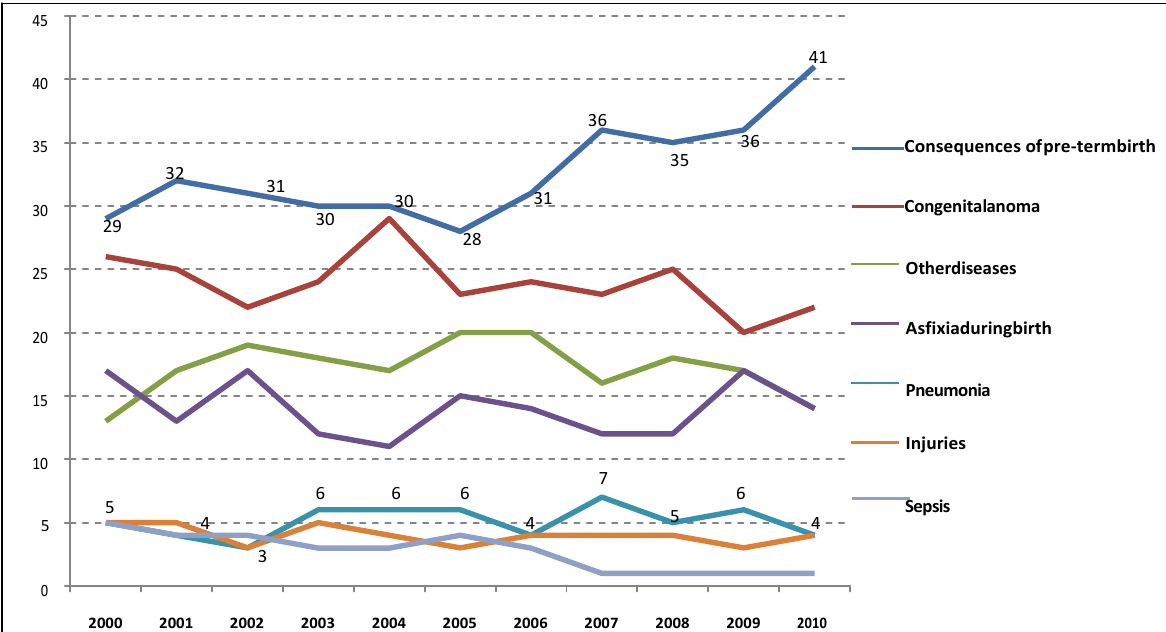
Figure 3. Distribution of the leading causes of death of children under-five